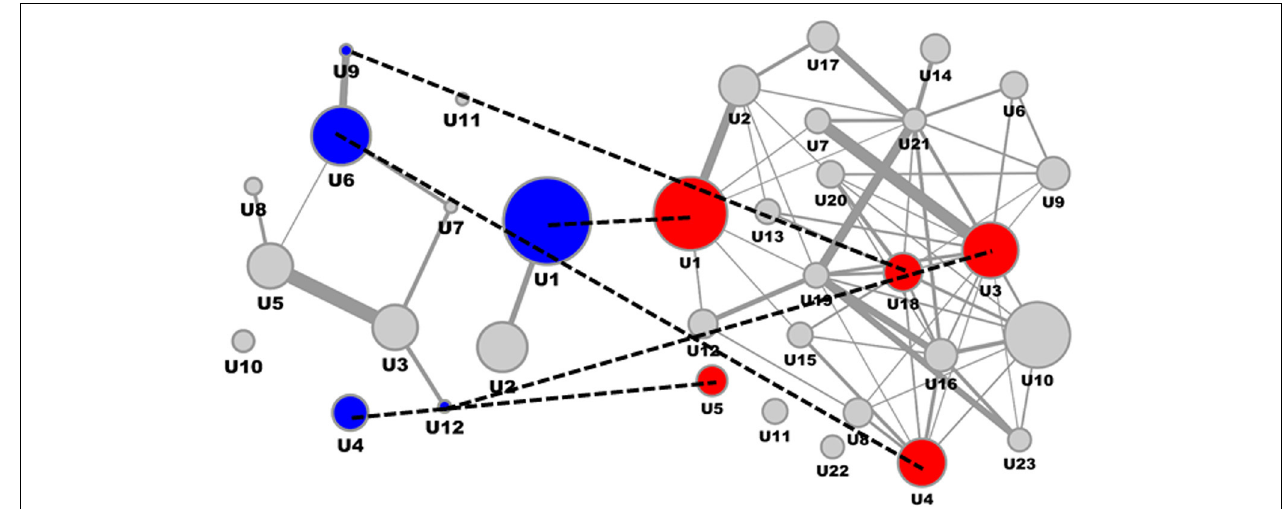
FIGURE 3 | ACE inhibitor mechanism of action molecular model and interference with DN molecular model. ACE Mechanism of Action molecular model (left) and DN molecular model (right), with overlapping process segments of drug and phenotype models indicated by dotted